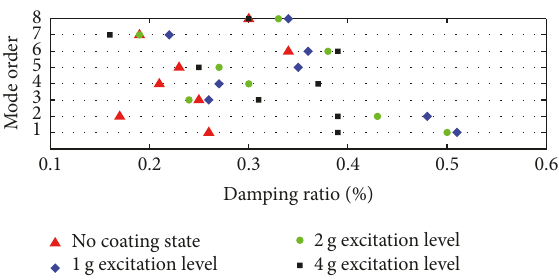
Figure 10: The scattergrams of damping ratios of cantilever cylin- drical shell coated with and without hard coating under different excitation